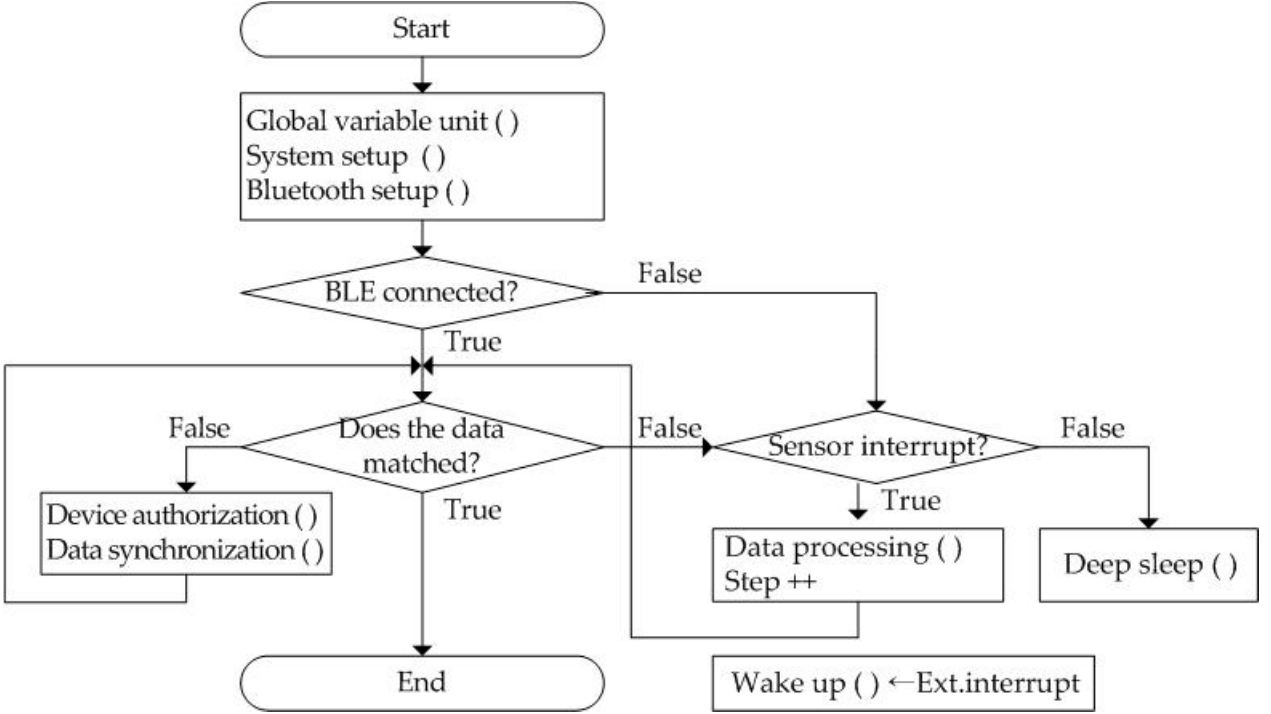
Figure 4. The operation flow of the proposed wearable band.